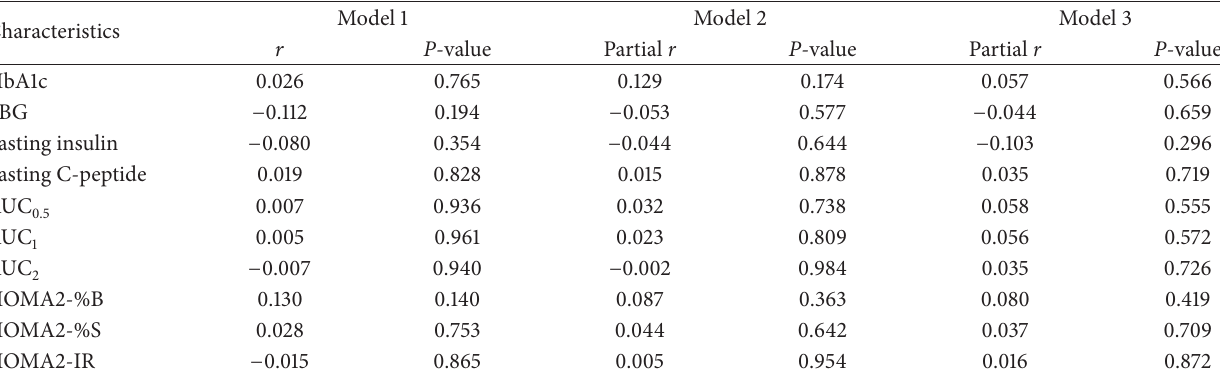
Table 3: Partial correlations between betatrophin levels and glucose-related variables in T2DM